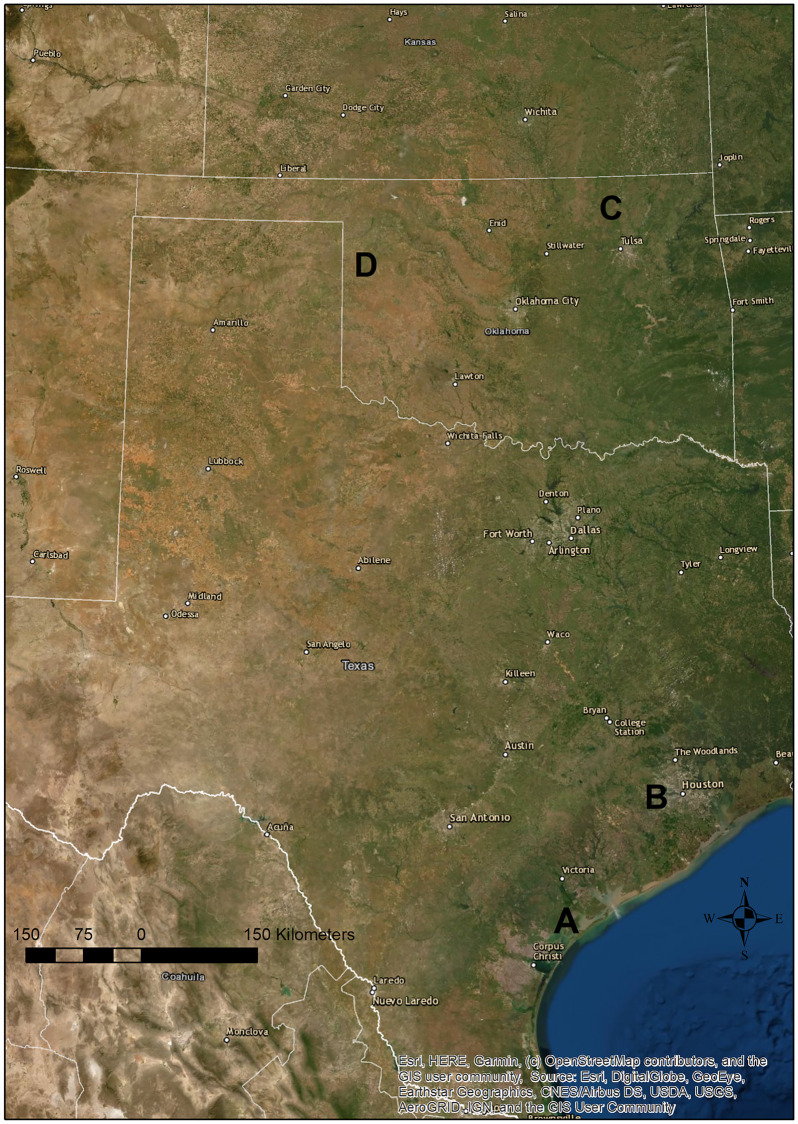
Study site map.Map showing approximate locations of each study site. A = Aransas National Wildlife Refuge (NWR); B = Attwater’s Prairie-chicken NWR; C = Tallgrass Prairie Preserve; D = Packsaddle Wildlife Management Area.